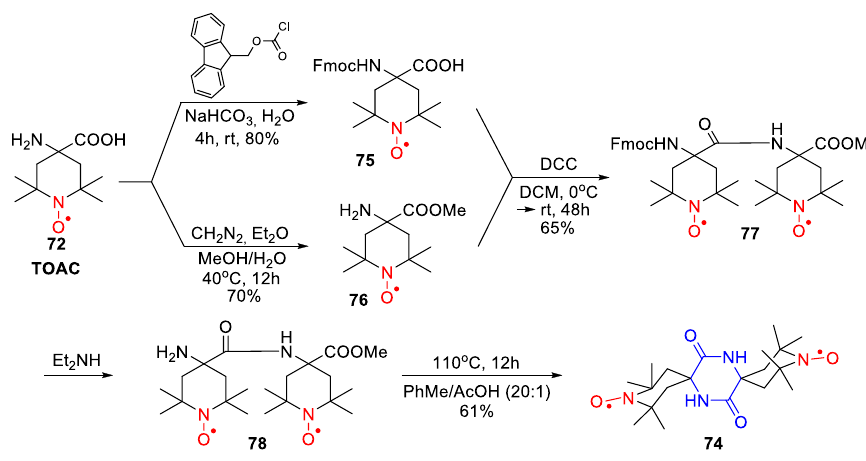
Figure 5. X-ray structure of dispirocyclic biradical 74 with a rigid diketopiperazine linker. A co- crystallized 1,1,1,3,3,3-hexafluoro-2-propanol (HFIP) molecule forms an H-bond between the N–O moiety and the hydroxy group of the solvent.